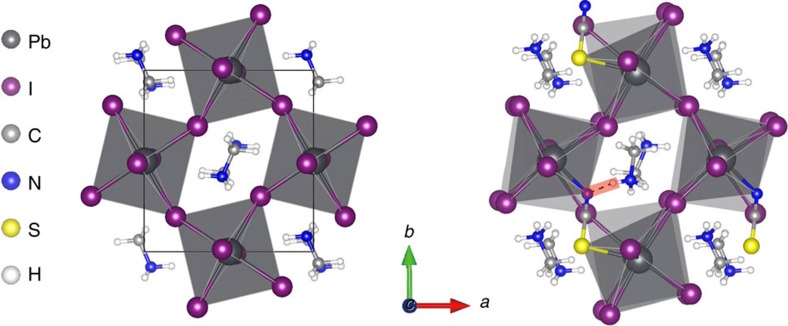
Theoretical calculation of perovskite materials.Calculated crystal structures of CH3NH3PbI3 (left) and CH3NH3PbI3−x(SCN)x based on a chemical formula of (CH3NH3)4Pb4I11SCN(right). The hydrogen bond between SCN− and CH3NH3+ (dash line) is highlighted with red colour.